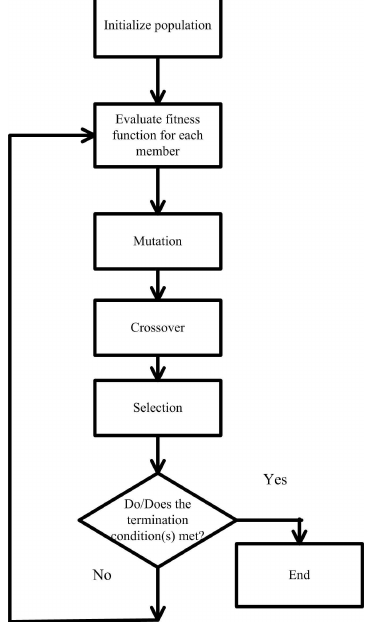
Figure 4. Flow-diagram of differen- tial